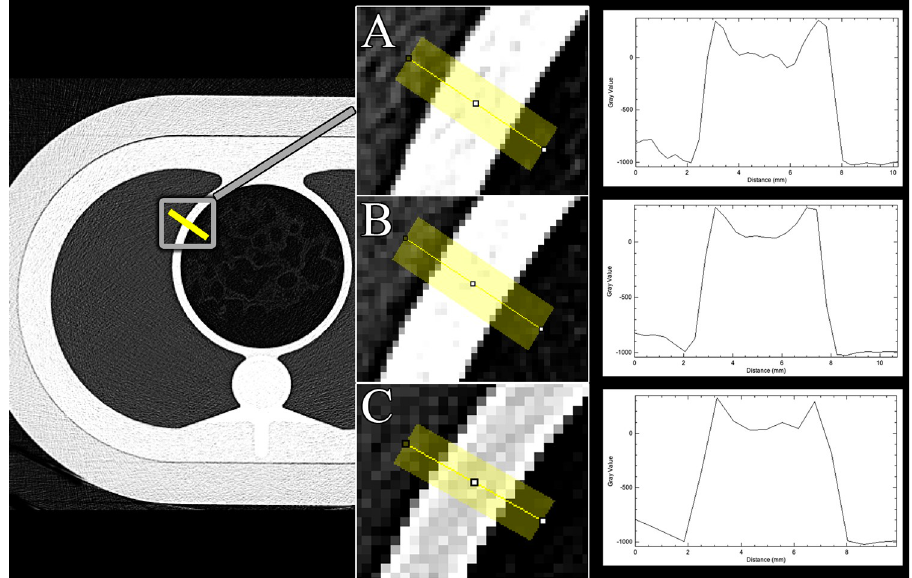
Fig 1. Assessment of image sharpness in the phantom. Chart shows the measurement principle of image sharpness in the phantom. CT attenuation profiles were measured along lines perpendicular to the circular central bore hole of the phantom. For each CT dataset the attenuation profile was measured at four different positions of the circular bore hole (1:30, 4:30, 7:30, 10:30 o’ clock position). Exemplary measurement profiles at the 10.5-position are shown for the 1024- (A), 768- (B), and 512-matrix, respectively. Note the increased stair-step artefacts using a 512-matrix